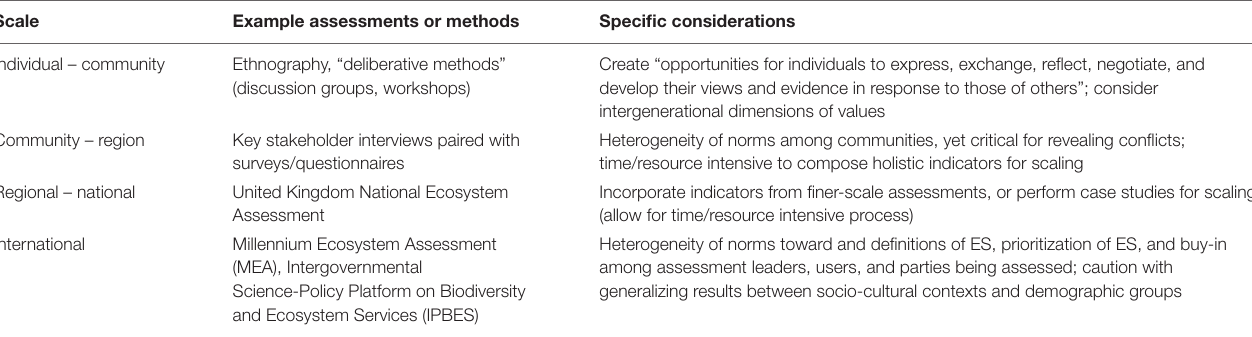
TABLE 1 | Across increasing demographic scales, examples of methods to elicit holistic values of individuals and groups, and specific considerations for assessments at that demographic scale. Scale